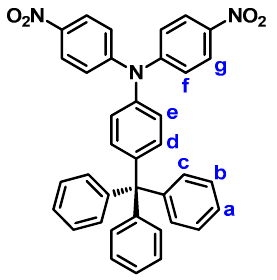
Figure 2. Structure and codes of hydrogen atoms of compound 2 .